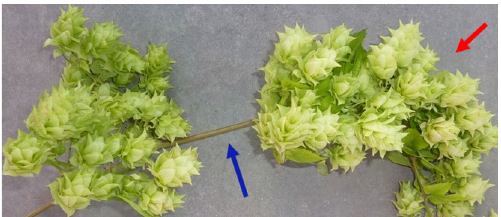
Figure 1. 67 days into the crop cycle a representative example of cultivar ‘Centennial’ hop cone production on a node where the internode was not previously bent (blue arrow and left side of photo) versus a subsequent node that was bent at 90° (red arrow and right side of photo). Moreover, the red arrow indicates a shorter internode that results in a higher density of cones along the length of the bine (90° bending), whereas to the left of the blue arrow indicates a sparser cone density sans bending.